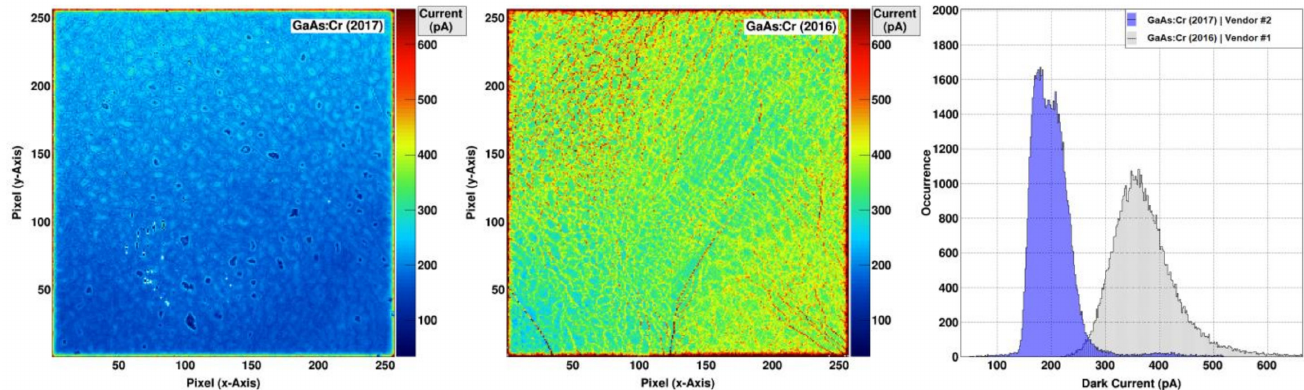
Figure 3. ( left ) Dark current map of the GaAs:Cr (2017) from vendor #2 and (middle) the GaAs:Cr (2016) sensor from vendor #1 measured at a temperature of +15 ◦ C. ( right ) Histogram of the dark currents of both GaAs:Cr sensors. The mean current per pixel is 201.6 pA with a dispersion of 17.3 % (vendor #2) compared to 391.0 pA with a dispersion of 16.9 % (vendor